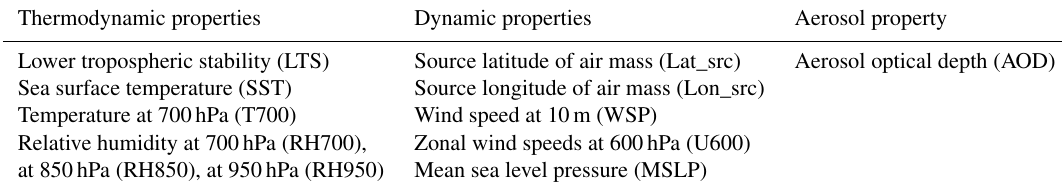
Table 2. Predictors and abbreviations used in the GBRT